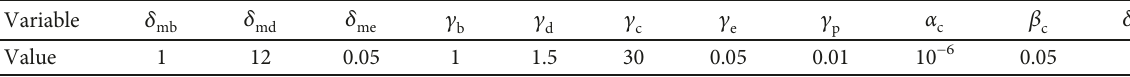
Table 1: Nondimensional parameters of the blisk.